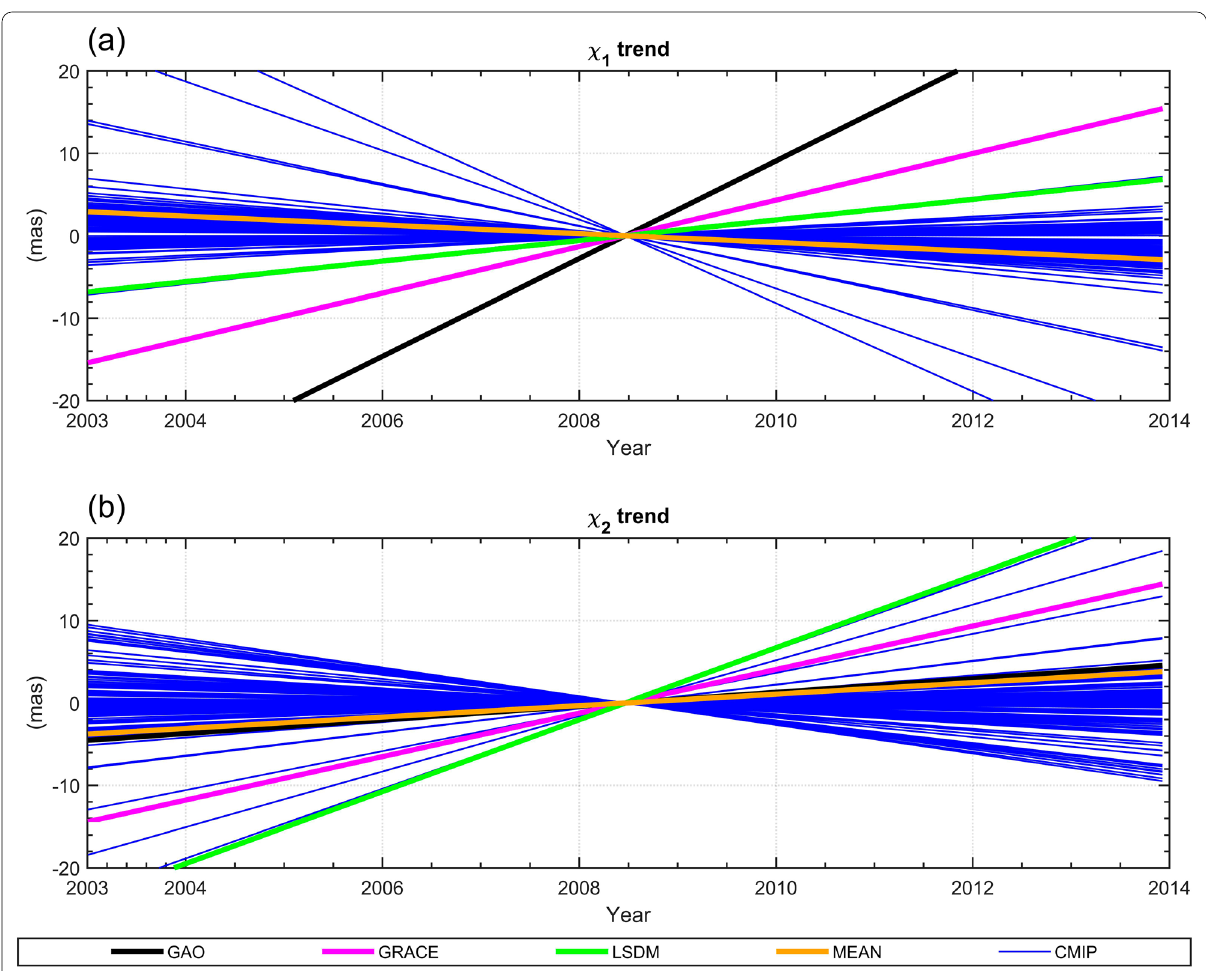
Fig. 1 Trends in χ 1 and χ 2 components of GAO and HAM computed from the GRACE, LSDM, CMIP6 models and MEAN